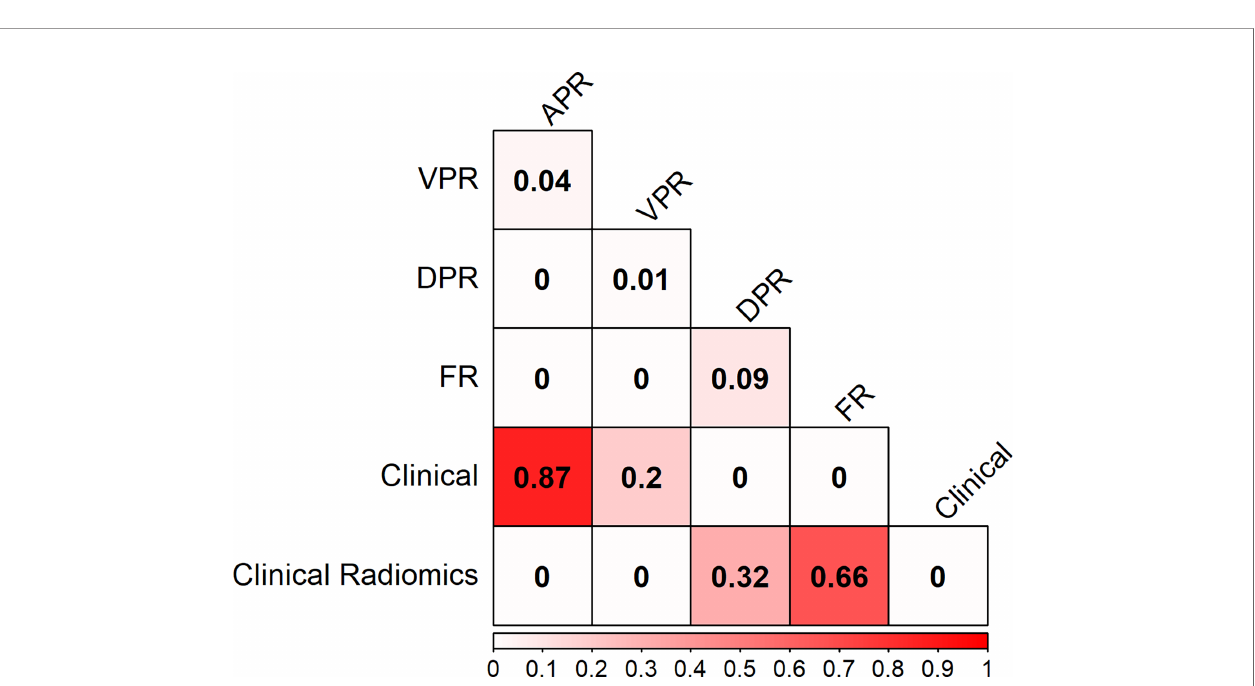
FIGURE 6 | Heat map comparison of the different models in the training cohort. The values in the matrix represent the results of Delong test between two models. APR, radiomics model of arterial phase; DPR, radiomics model of delayed phase; VPR, radiomics model of venous phase; FR, radiomics model of fusion of arterial phase, delayed phase and venous phase features; Clinical Radiomics, fusion of clinical risk factors and radiomics features of delayed